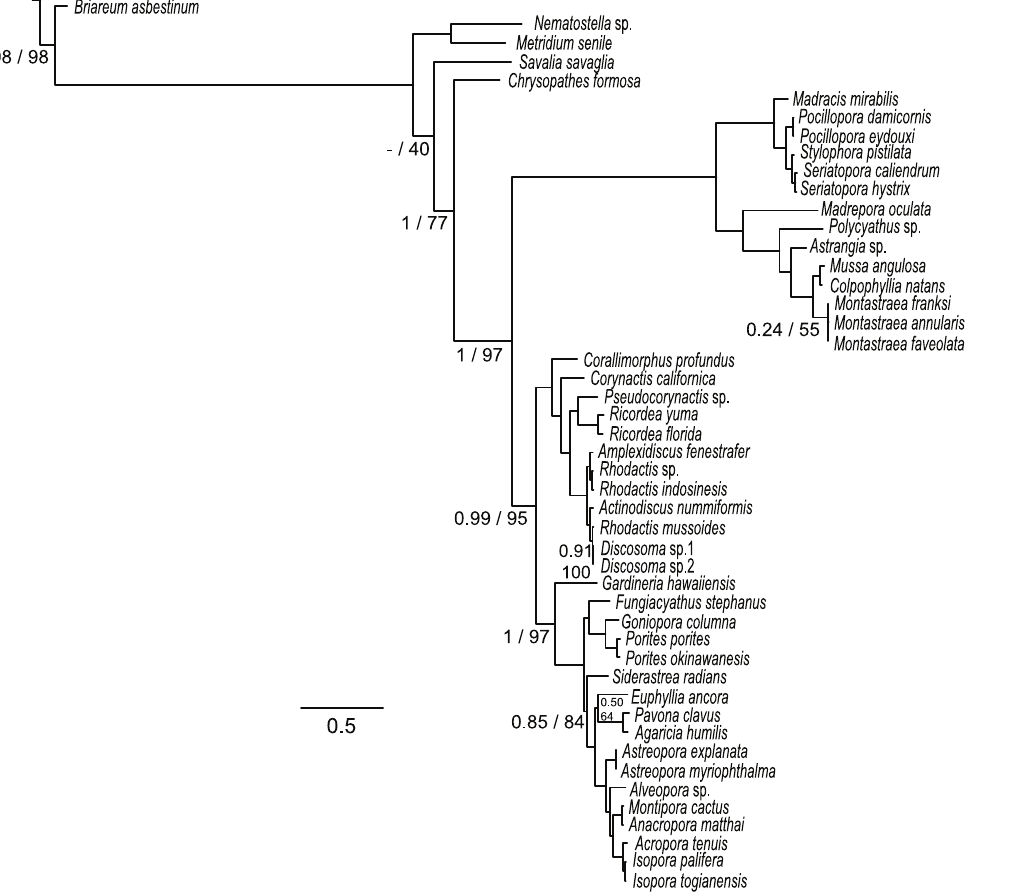
Figure 4. Codon-based phylogenetic analyses inferred using CodonPhyml – Yap et al. model [52] for Maximum Likelihood – and MrBayes – GTR substitution model and three categories of non-synonymous/synonymous ratios (M3 model). Values on the nodes indicate the non-parametric SH test and bootstrap replicates (ML), and posterior probability (BI) support respectively. Where no values are shown on a node, that edge was fully supported under all analyses.